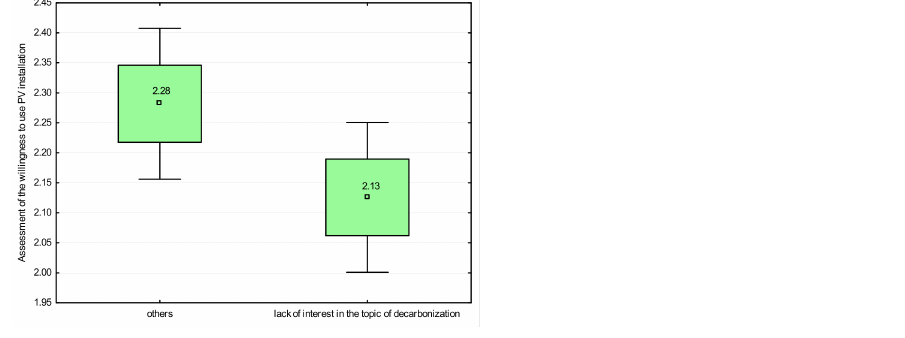
Figure 16. What is the biggest barrier to decarbonization in transport (lack of public interest in decarbonization) vs. assessment of the willingness to use PV installations.